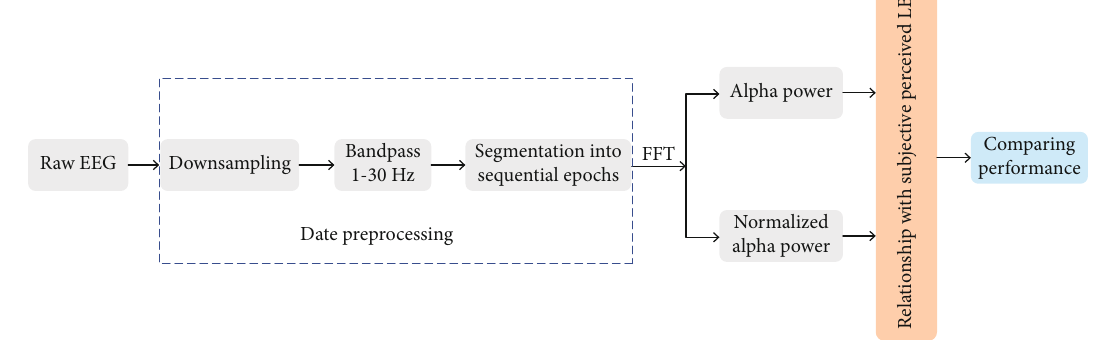
Figure 1: Flowchart describing the procedure used for EEG data